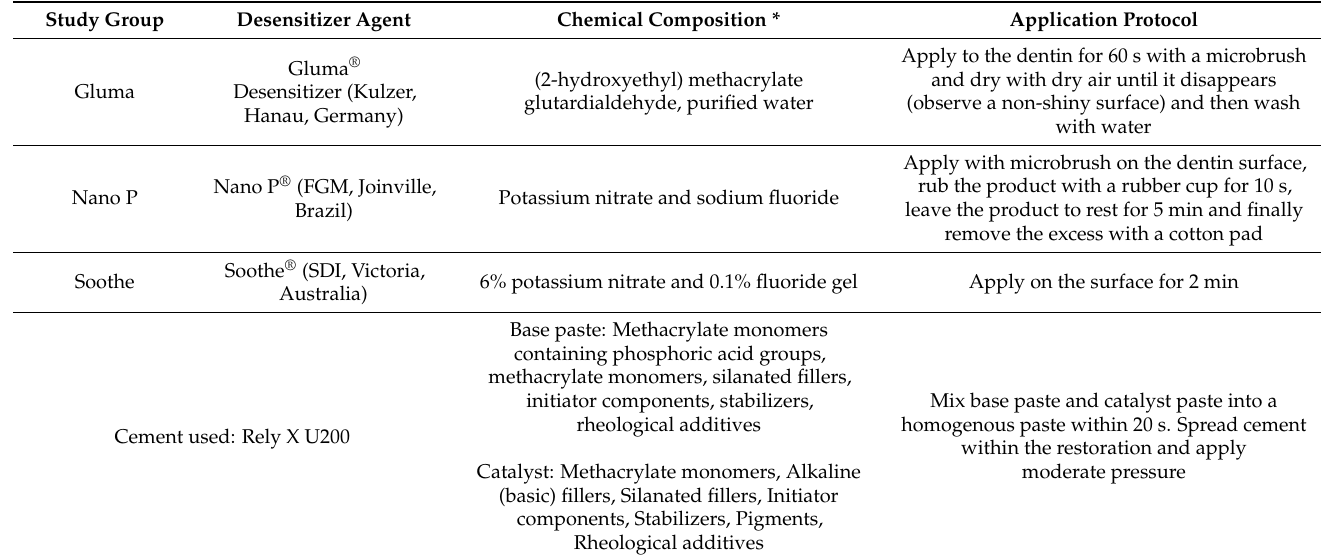
Table 1. Chemical composition and application protocols of the materials used in this